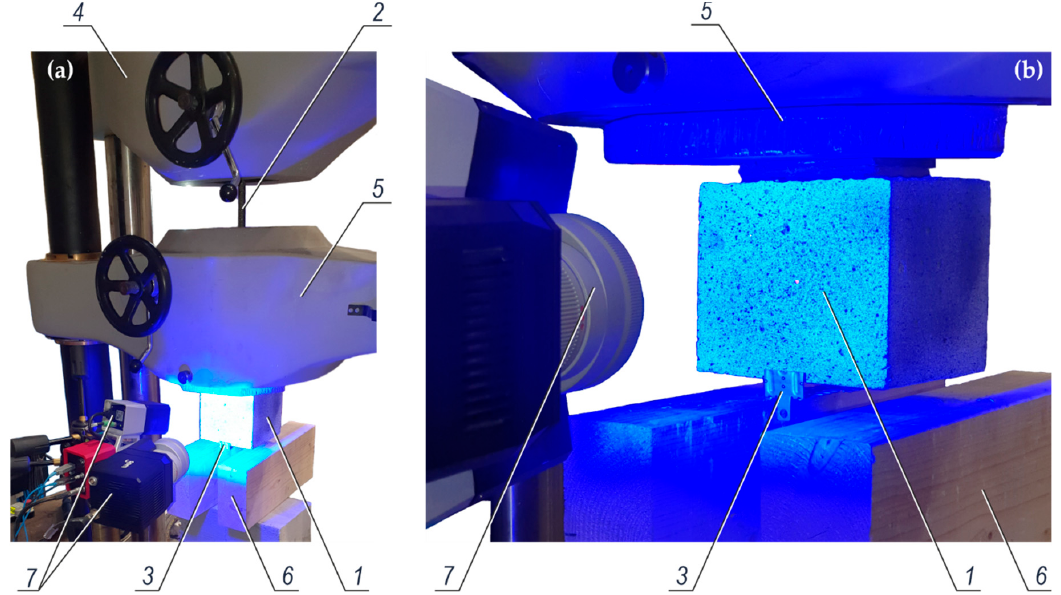
Figure 5. The Aramis system of cameras from the GOM company used on stage 2 and 3 of testing the force pulling out the rebar from concrete: ( a ) view of the whole test stand, ( b ) view during measurements of the concrete specimen with a spot sprayed graphite paint; 1 —concrete specimen, 2 —a steel rebar pulled out from concrete in the specimen, 3 —a bar with glued permanent measuring points, 4 —the top holder of the test machine, 5 —the bottom holder of the test machine, 6 —wood beams to support the concrete specimen after the rebar pullout, 7 —cameras recording the